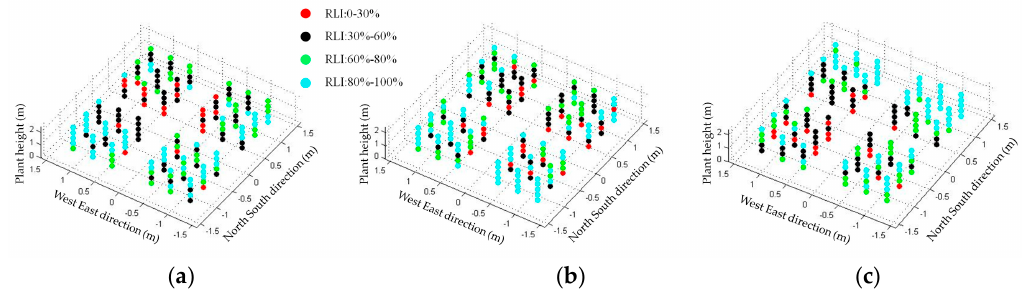
Figure 6. Distribution of RLI within canopies. ( a ) The first tree; ( b ) The second tree; ( c ) The third tree.